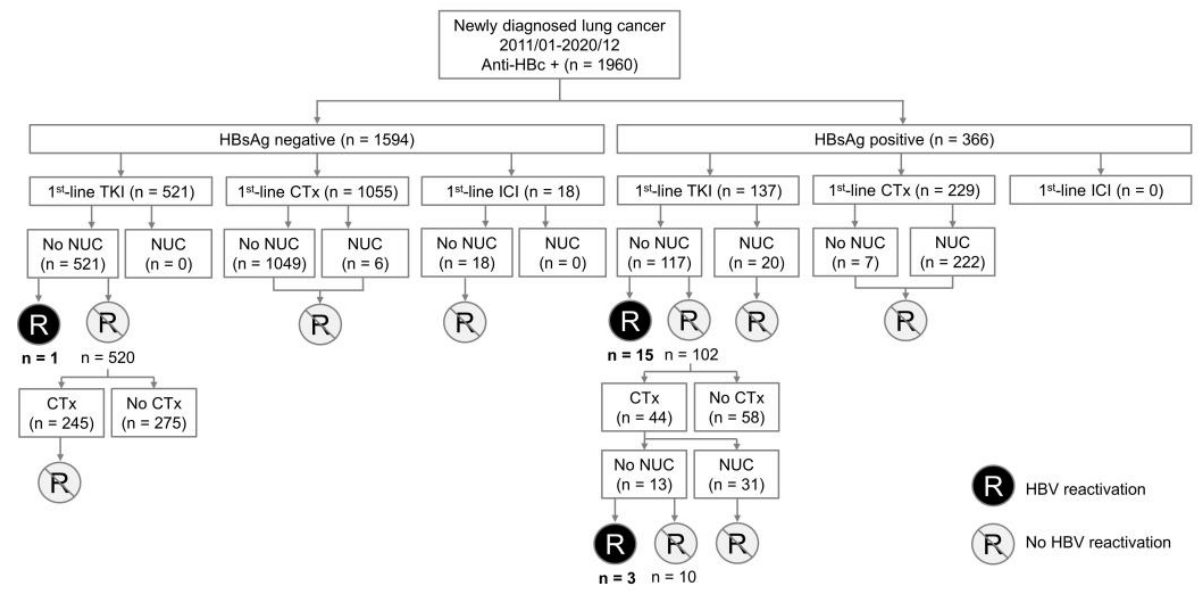
Figure 1. Algorithm for study participants enrollment and the risk of hepatitis B reactivation in various conditions. CTx, chemotherapy; HBV, hepatitis B virus; ICI, immune checkpoint inhibitor; NUC, nuceos(t)ide analogues; TKI, tyrosine kinase inhibitor.